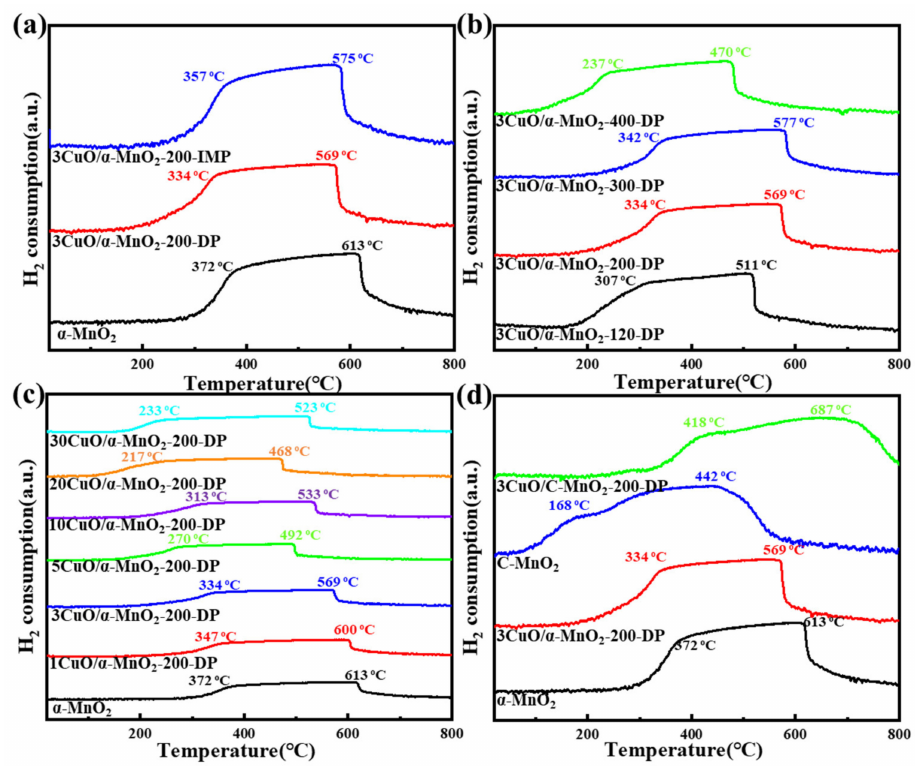
Figure 8. H 2 -TPR profiles of ( a ) α -MnO 2 , 3CuO/ α -MnO 2 -200-DP and 3CuO/ α -MnO 2 -200-IMP catalysts under different loading methods; ( b ) 3CuO/ α -MnO 2 - T -DP ( T = 120, 200, 300, 400) cat- alysts with different calcination temperatures; ( c ) x CuO/ α -MnO 2 -200-DP ( x = 0, 1, 3, 5, 10, 20, 30) catalysts with different CuO loading; ( d ) α -MnO 2 nanowire, commercial MnO 2 (C-MnO 2 ) and corresponding